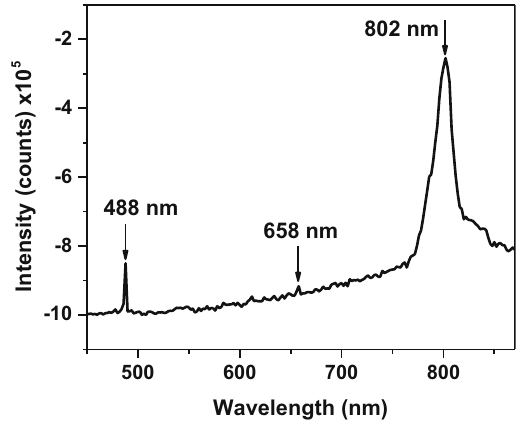
Figure 17: Upconversion emission spectrum of PMMA + NaY 0.88 F 4 :Yb 3 + 0.1 Tm 3 + 0.02 nanocomposite fi lm made by open - air CMBMT - PLD. The fi lm was pumped with a 200 mW 980 nm